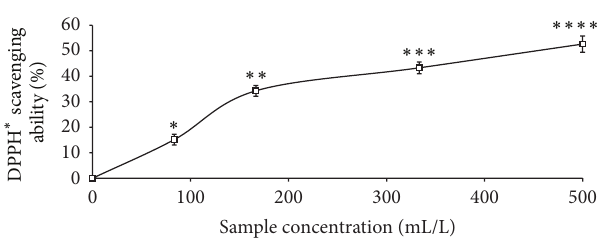
Figure 1: DPPH radical scavenging ability of essential oils from black pepper. Values represent means ± standard deviation of triplicate readings.